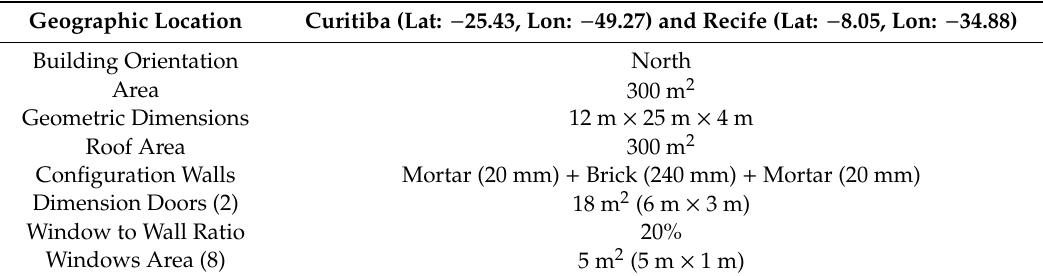
Table 2. Summary of building input data.